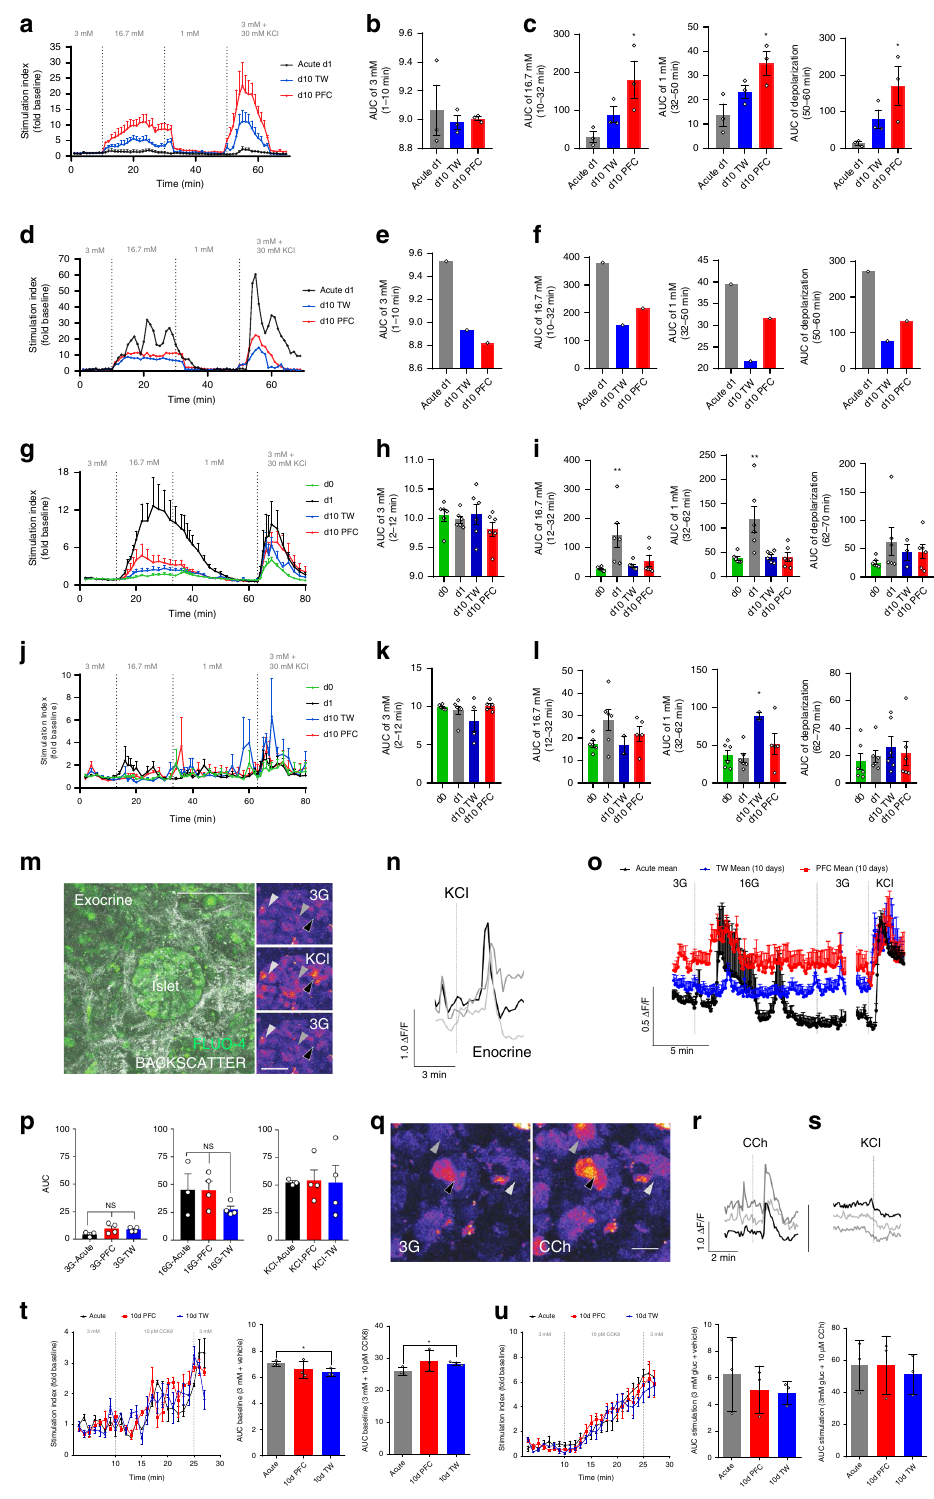
Figure 3j – l also shows dynamic glucagon secretion with glucose stimulation. Although glucagon responsiveness is more dif fi cult to measure in HPSs due to the smaller number of alpha cells in each sample, the rapid peak detected immediately after 1 mM (low) glucose in the PFC group (Fig. 3j, red trace) is physiological, unlike the delayed one observed in long-term transwell-cultured HPSs (Fig. 3j, blue trace).